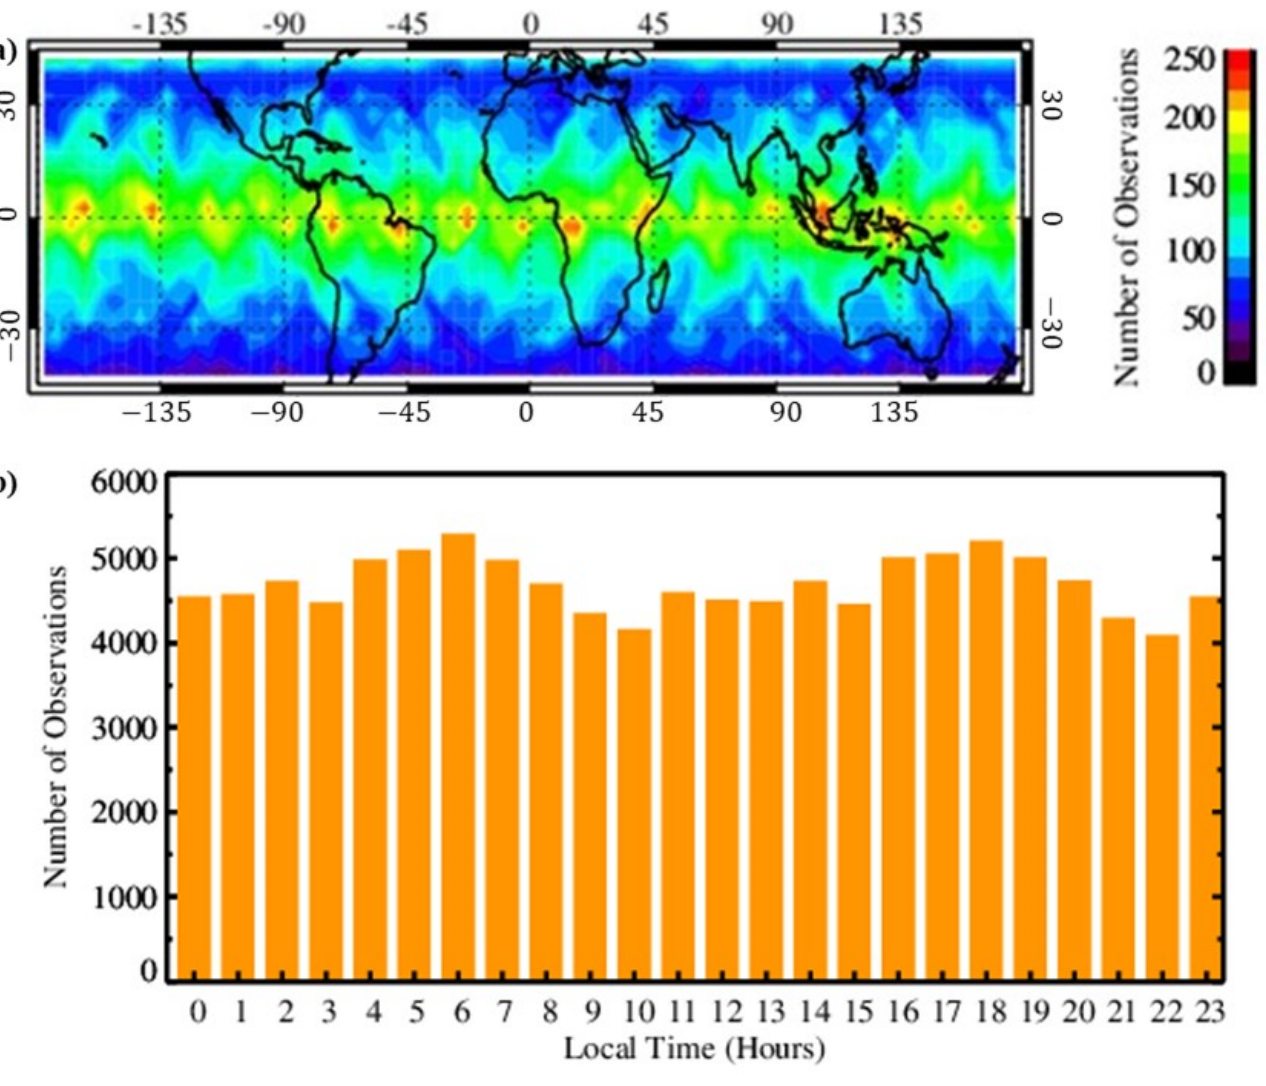
Figure 3. Distribution of COSMIC-2 observations ( a ) in the region ± 45 ◦ latitude at 5 × 5 ◦ longitude and latitude bins and ( b ) at local solar times for the region ± 30 ◦ latitude using observations from 1–31 October 2019.